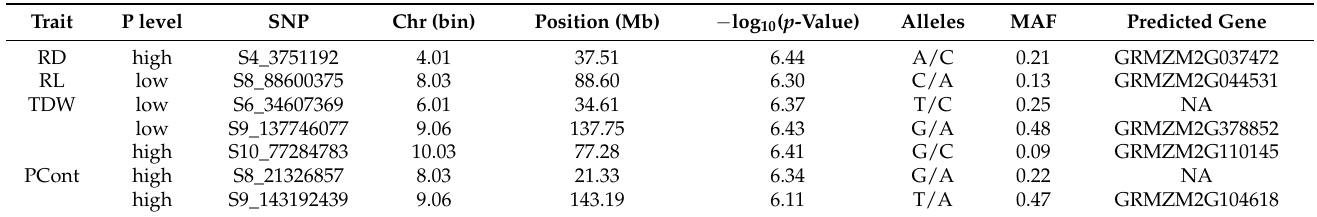
Table 4. Significant SNPs identified with mixed linear models (MLM) analyses for root morphology traits, total seedling dry weight and P content for low- and high-P conditions, based on a –log 10 ( p - value) ≥ 6.07. The bin, position, alleles, minor allele frequency (MAF) and nearby candidate genes with a maximum distance of 1 kb are